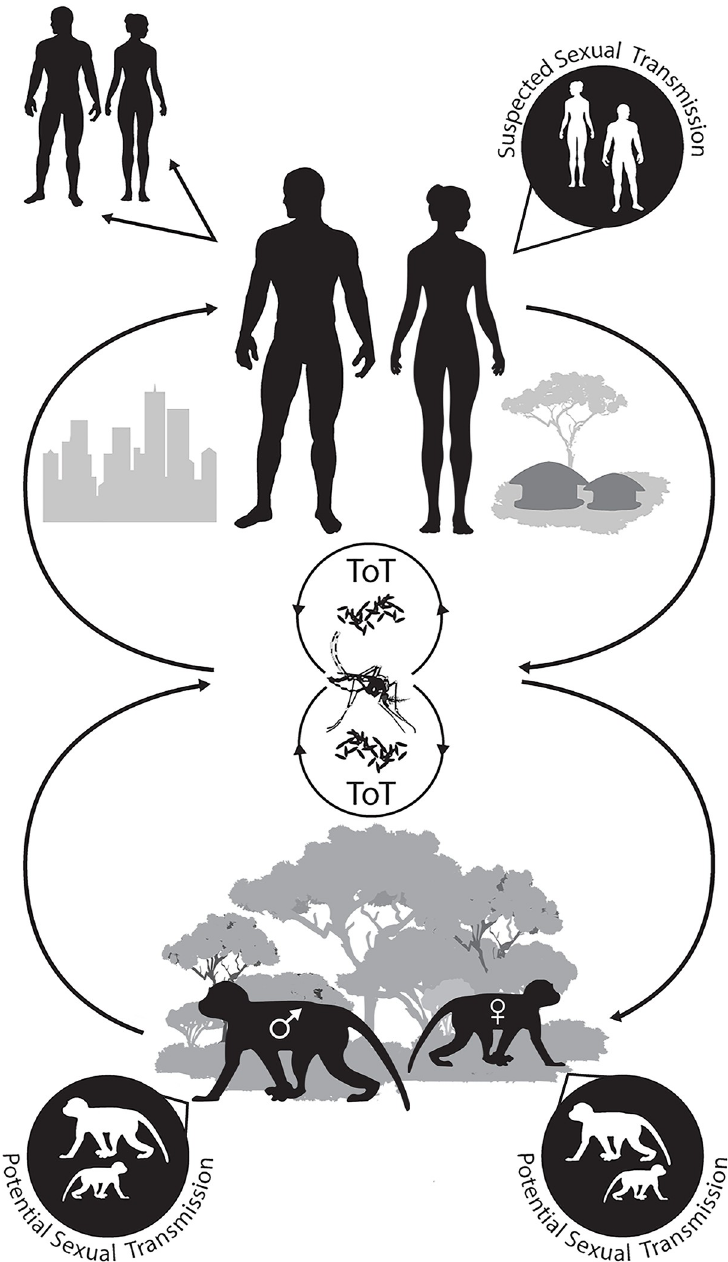
Fig 1. Zika virus transmission and maintenance